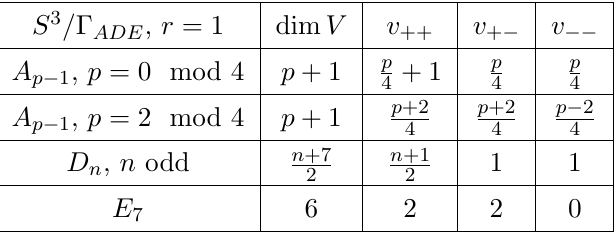
Table 4 . Dimensions of the eigenspaces V